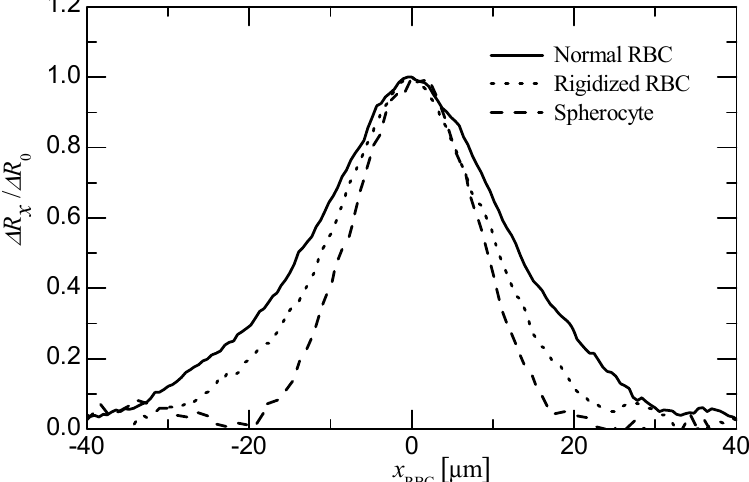
( a ) Resistance distribution Δ R